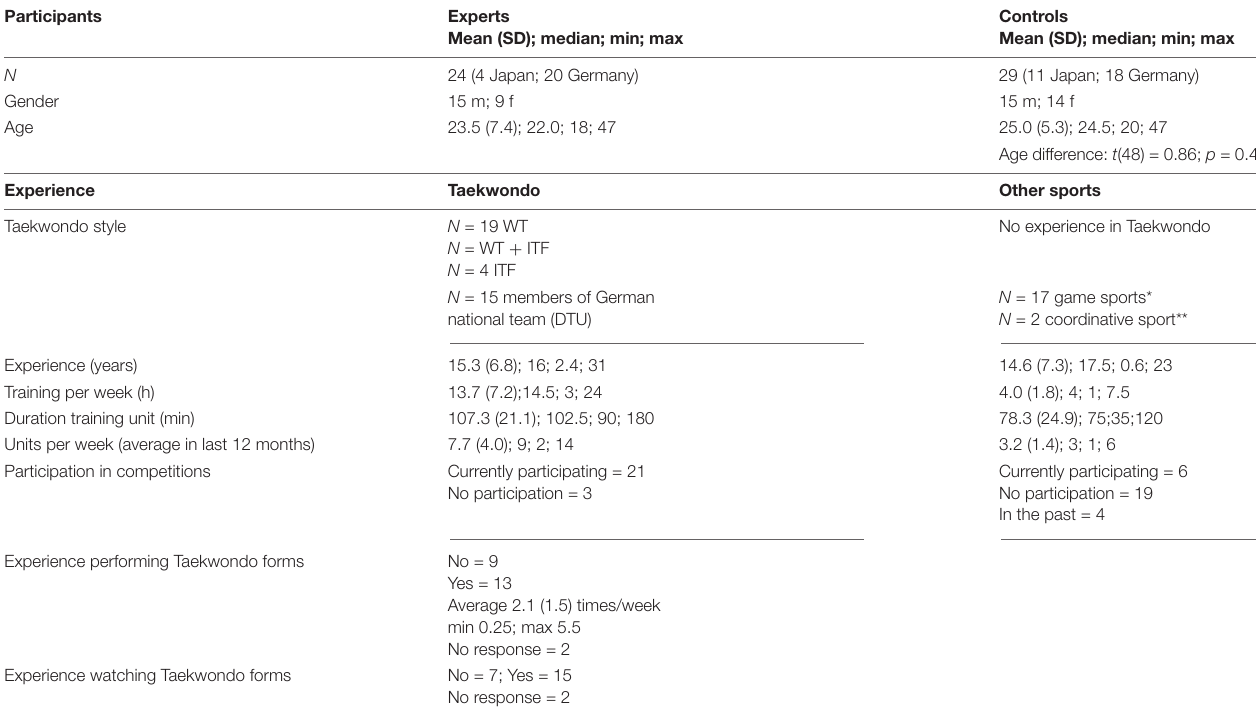
TABLE 1 | Details of participant